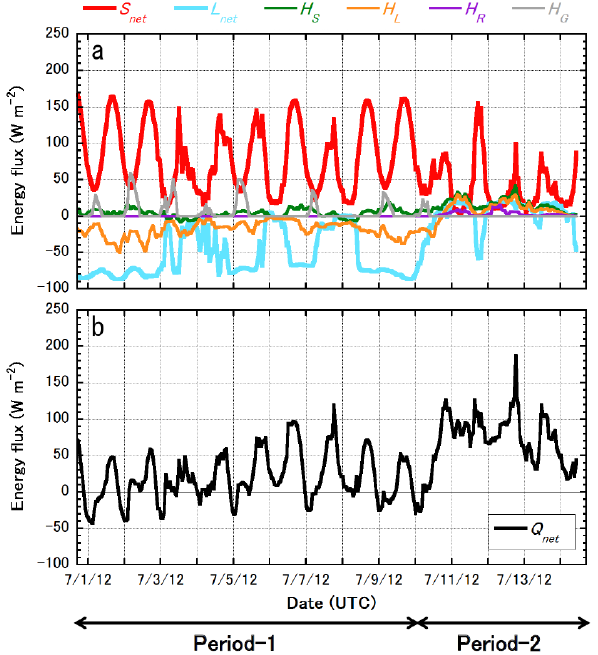
Figure 10. One-hour averaged surface energy balance at the SIGMA-A site during the IOP. The upper panel (a) shows net short- wave radiant flux ( S net ), net long-wave radiant flux ( L net ), sensible heat flux ( H S ), latent heat flux ( H L ), heat supply by rainfall ( H R ), and subsurface conductive heat flux ( H G ). These fluxes are defined to be positive when they are directed into the snow surface. The lower panel (b) denotes net energy flux ( Q net ). The snow surface is heated when Q net is positive, whereas it is cooled if Q net is nega- tive.